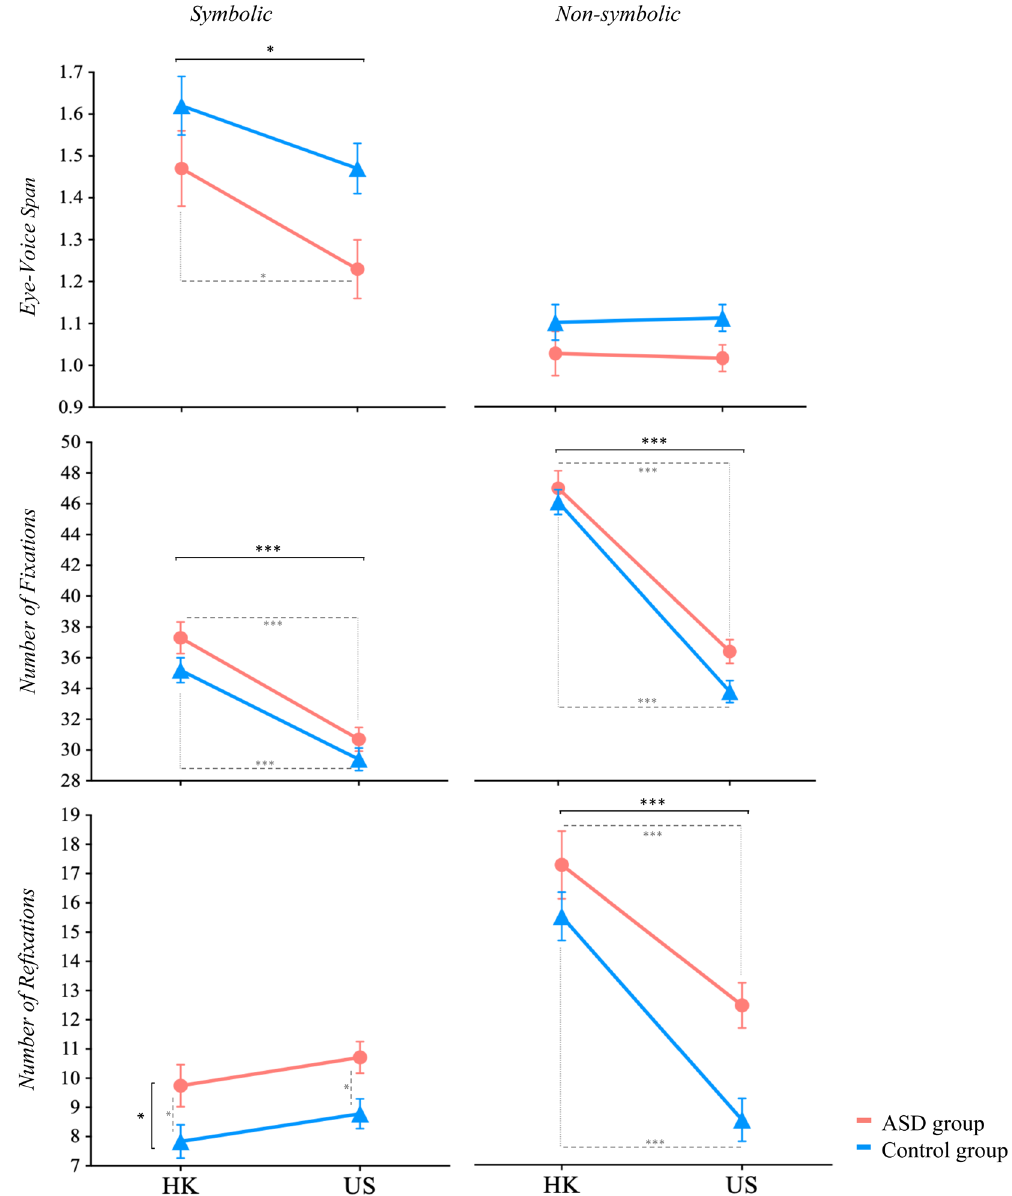
Figure 2. RAN eye-movement variables across cultures, diagnostic groups, and conditions. Culture effect for EVS symbolic condition ( Estimate = − 0.23, p < .05) and total fixations across conditions (Estimates < -6.52, p s < .0001). Diagnostic effect for refixations during symbolic condition ( Estimate = −0.190, p < .05) and culture effect during non-symbolic condition ( Estimate =− 4.77, p < .001). Error bars represent standard error of the mean (SEM). For US-ASD versus US-control group comparisons, refer to Nayar et. al., 2018 8 . * p < .05, ** p < .01, *** p < .001. Black overall bars denote significance of the overall model (i.e., group effect, diagnosis effect), and dashed grey lines indicate pair-wise